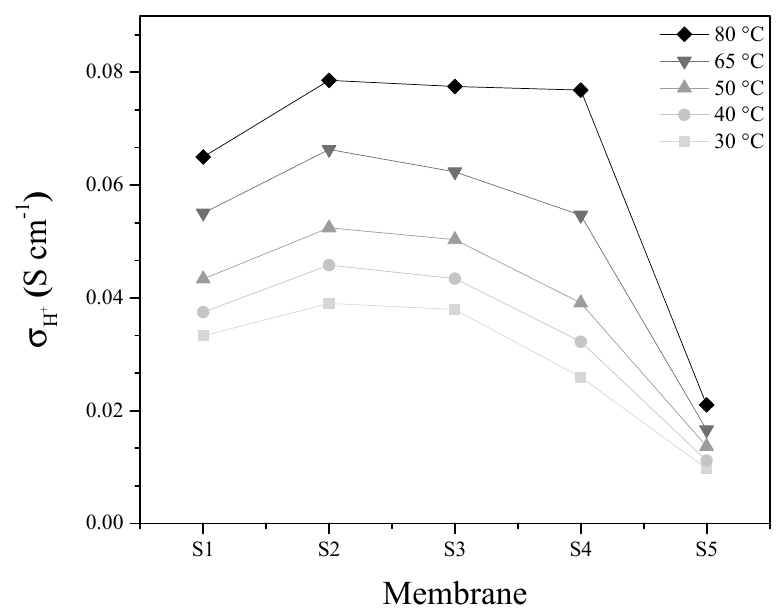
Figure 5. Proton conductivity at different temperatures as a function of composite polymer.